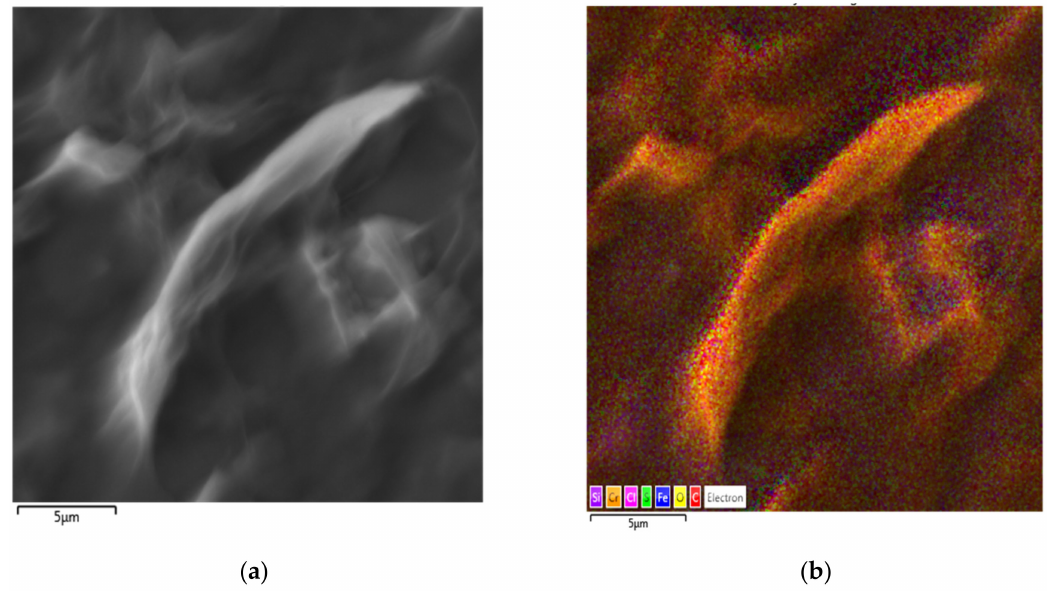
Figure 15. SEM characterizations of electrophoretically deposited GO film (scale 5 µ m); ( a ) SEM image, ( b ) EDX image.